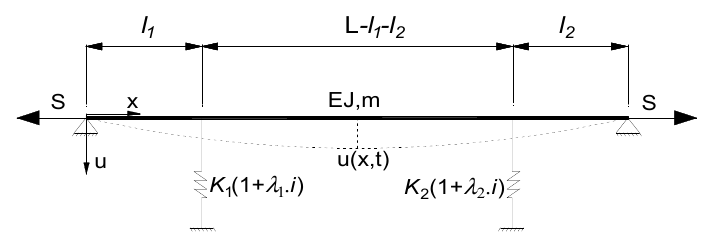
Figure 1. A stay cable with two HDR dampers.